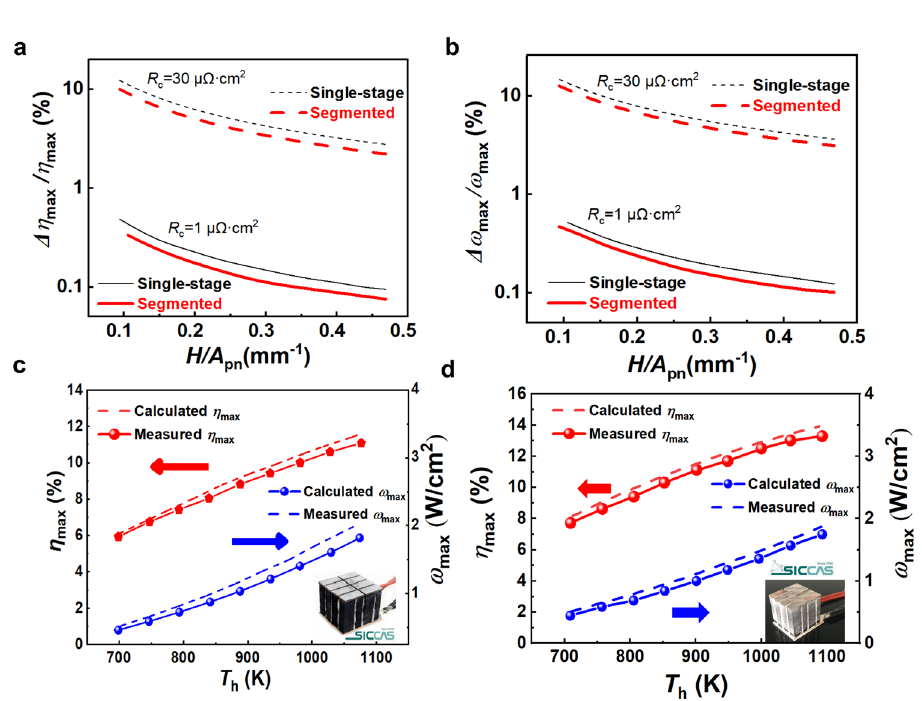
Fig.5|Outputperformanceofmodule.a Calculatedlossofmaximumconversion ef fi ciency Δ η max / η max , b calculatedlossofmaximumpowerdensity Δ ω max / ω max asa function of H/A pn and interfacial resistivity ( R c ) for different modules. The